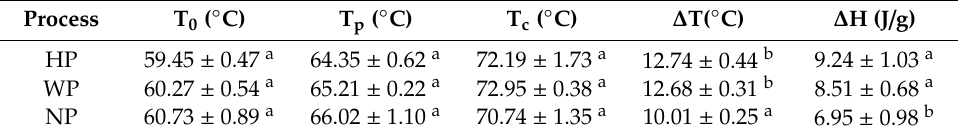
Table 3. Gelatinization properties of djulis starch by the three treatment procedures.